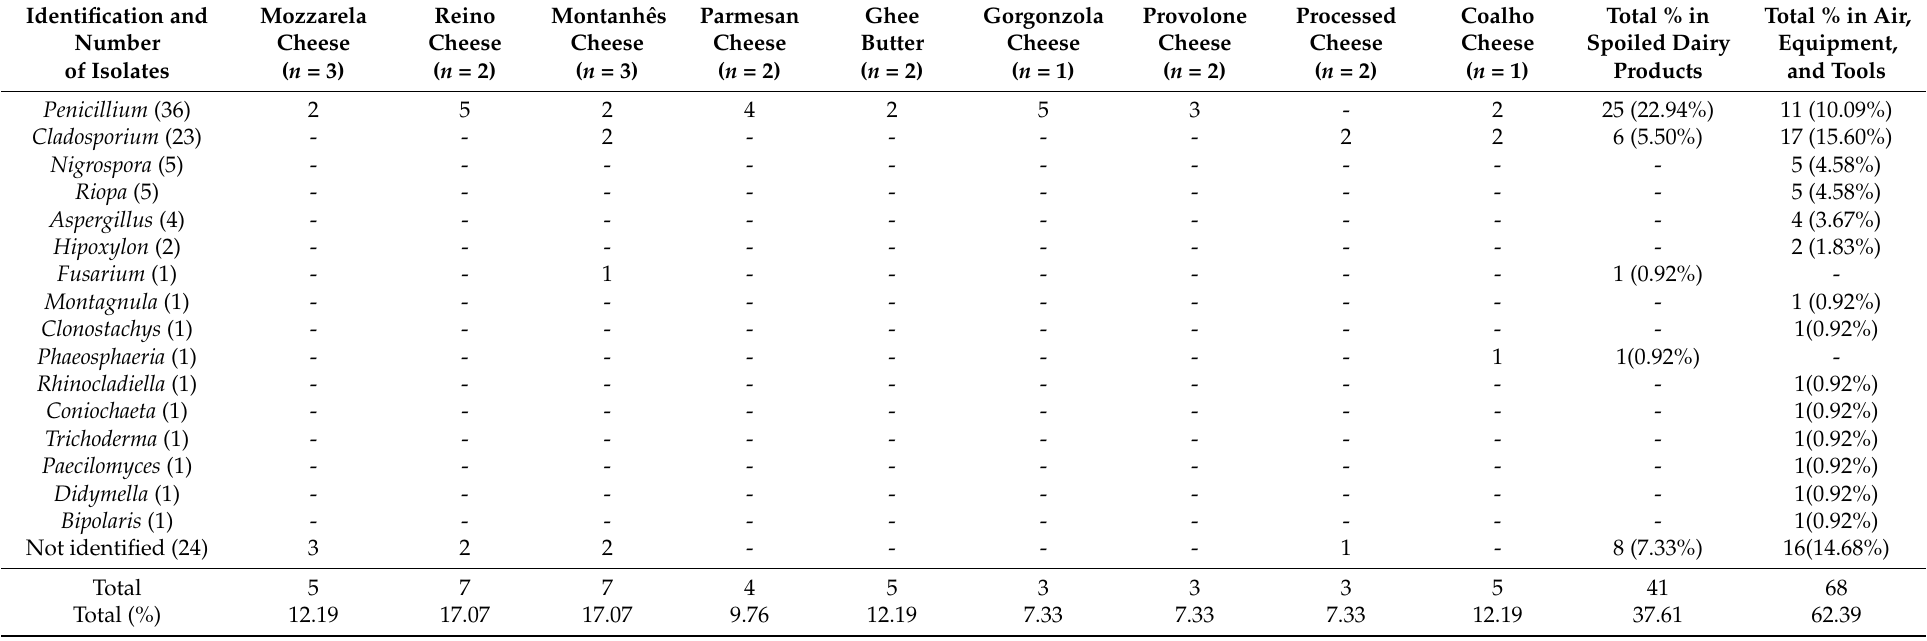
Table 1. Diversity and number of fungi isolated from spoiled dairy products ( n = number of